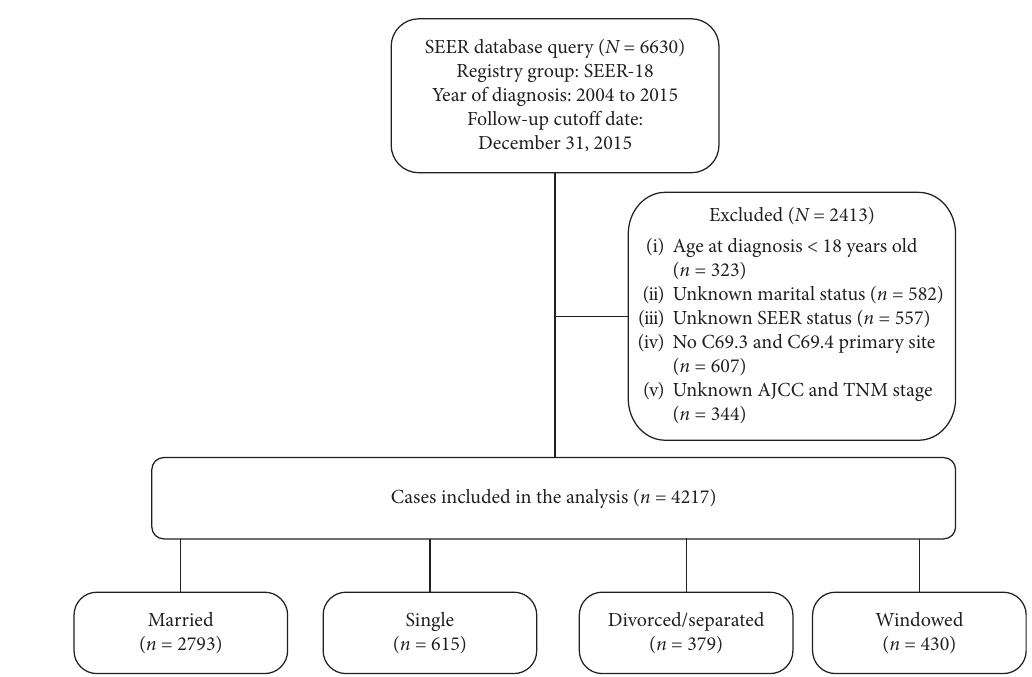
Figure 1: Flowchart describing the inclusion and exclusion of